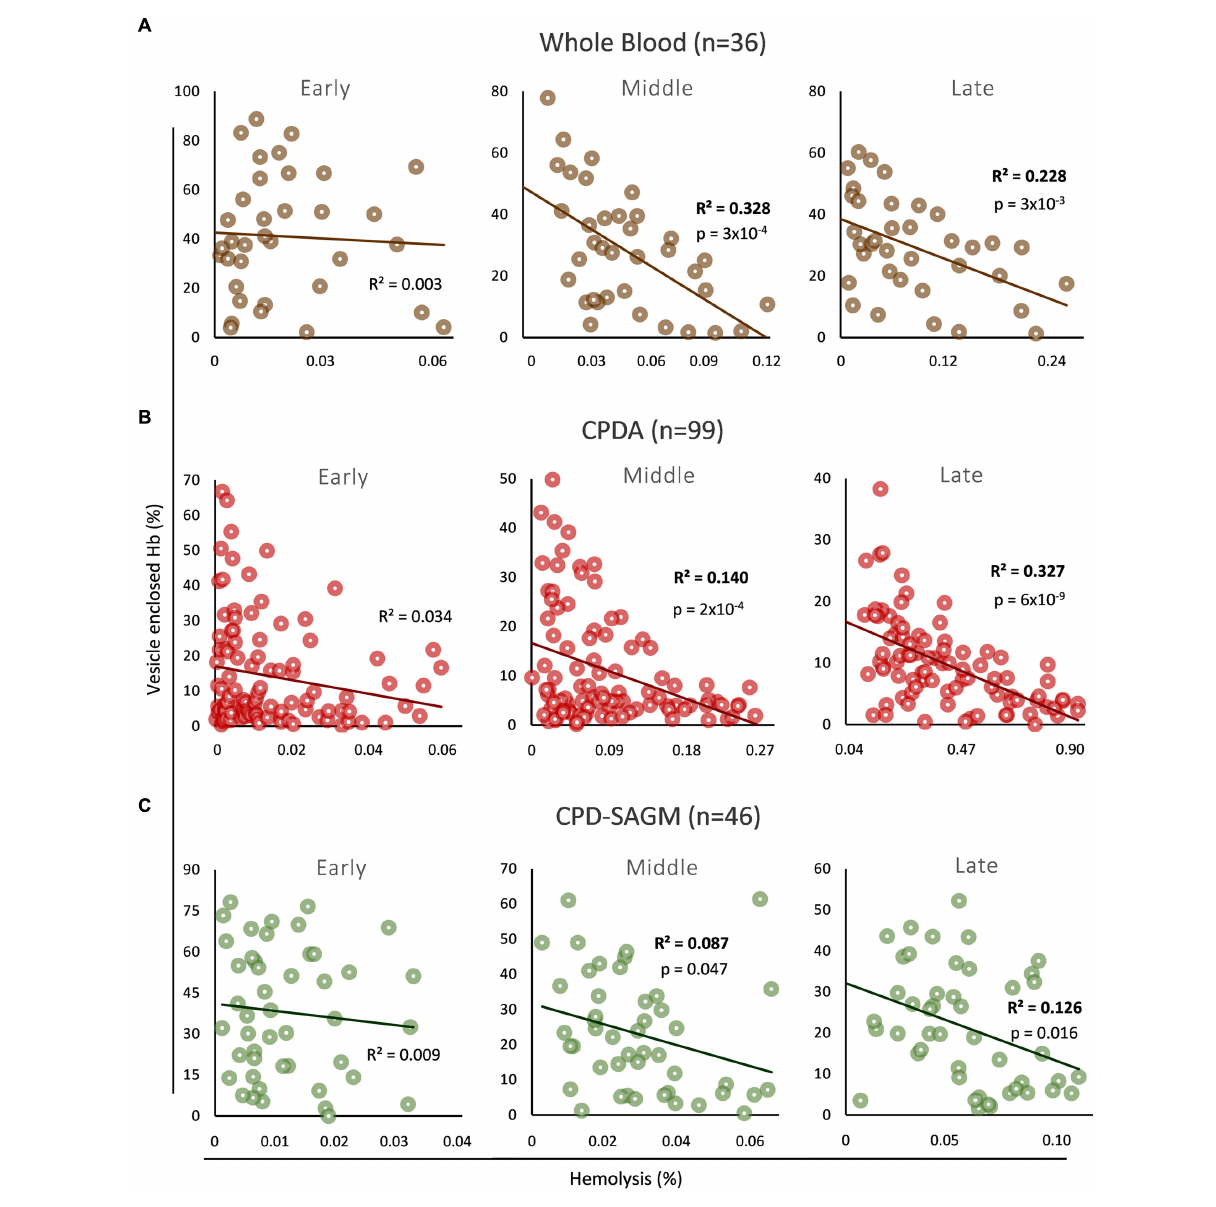
FIGURE 1 | Correlation between vesicle-enclosed hemoglobin (Hb) and storage hemolysis in blood bank conditions. Scatter plots showing the correlation between total free and vesicle-enclosed Hb during early, middle and late storage in (A) whole blood, (B) CPDA, and (C) CPD-SAGM